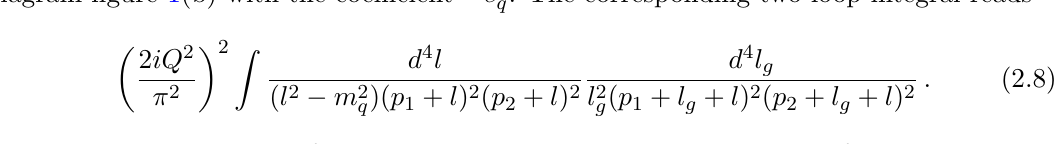
Figure 2 . The two-loop Feynman diagrams for the quark scattering by the ( G a (black circle) which contribute in the double-logarithmic approximation. Symmetric diagrams are not